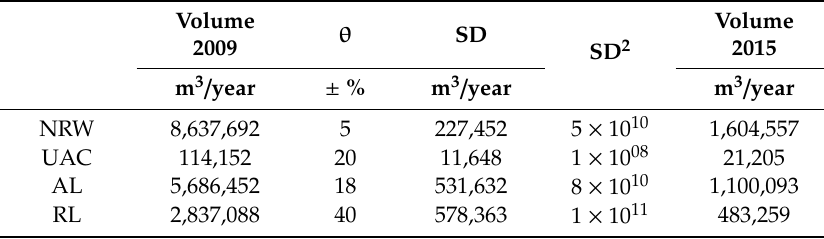
Table 1. NRW components and uncertainties.